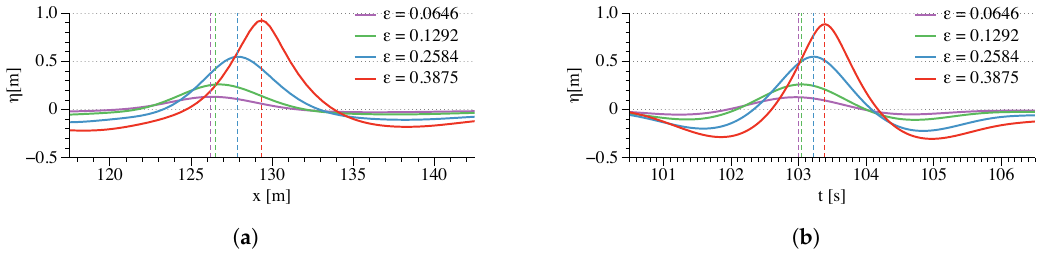
Figure 16. Comparison of the wave surface elevations at the respective real focusing time and location with four different wave steepnesses, ( a ) the wave profiles in the longitudinal direction, ( b ) the time series at the respective real focusing location.